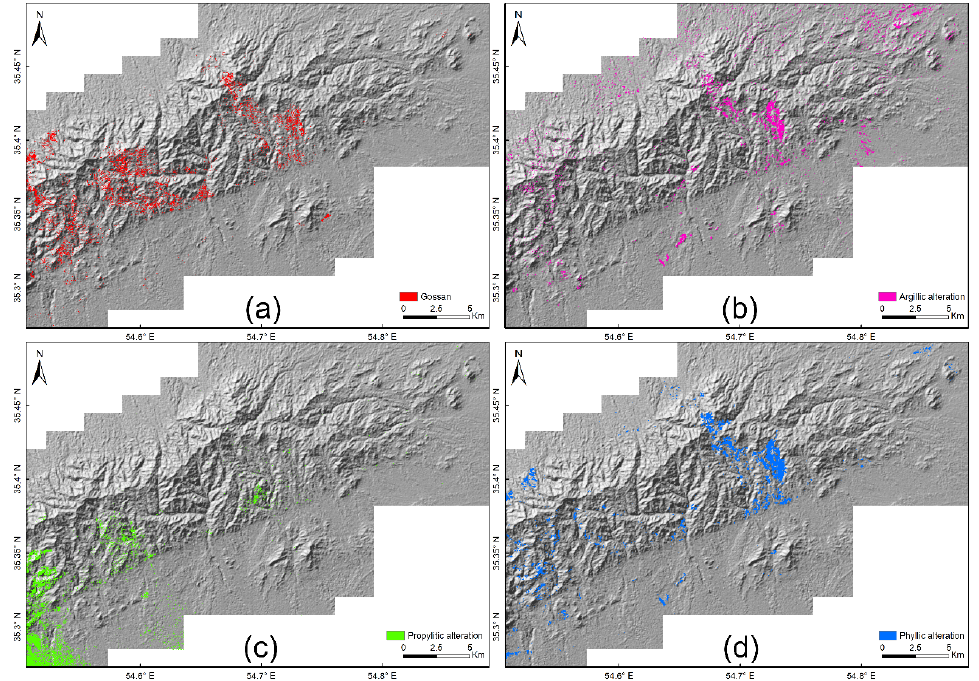
Figure 6. Anomalous pixels of different principal components determined using the C-A plots for enhancing (a) gossans, (b) argillic, (c) propylitic, and (d) phyllic alteration zones, overlaid on the hillshade of the study area.